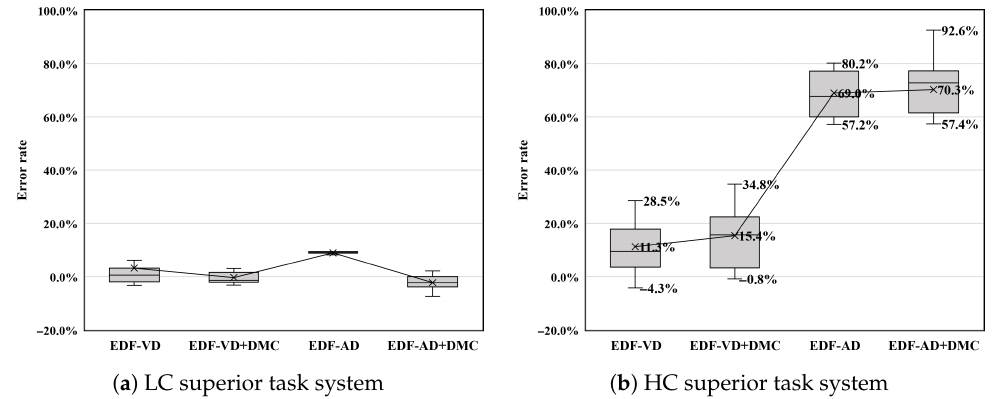
Figure 8. Violation test result of LC mode HC tasks with mode-switch triggered deadline test on ( a ) LC superior task system (HC:LC = 35:47) and ( b ) HC superior task system (HC:LC =